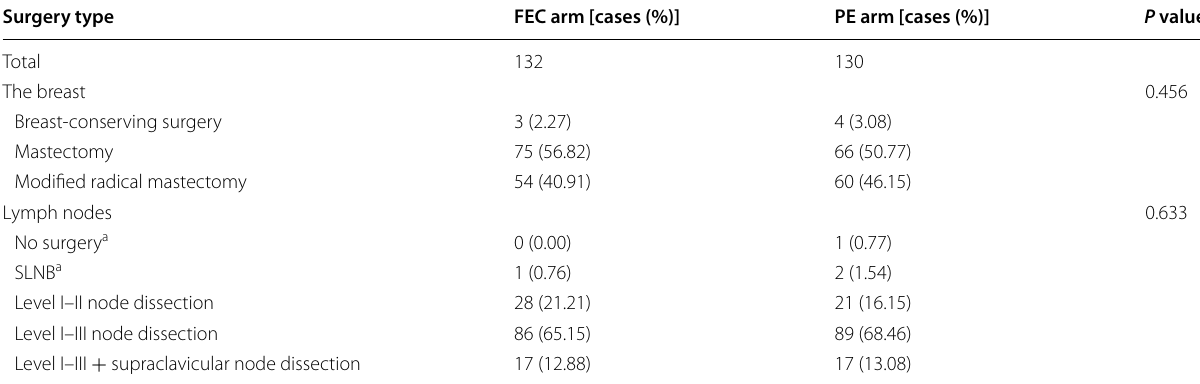
Table 4 Surgical breast and lymph node management for the FEC and PE